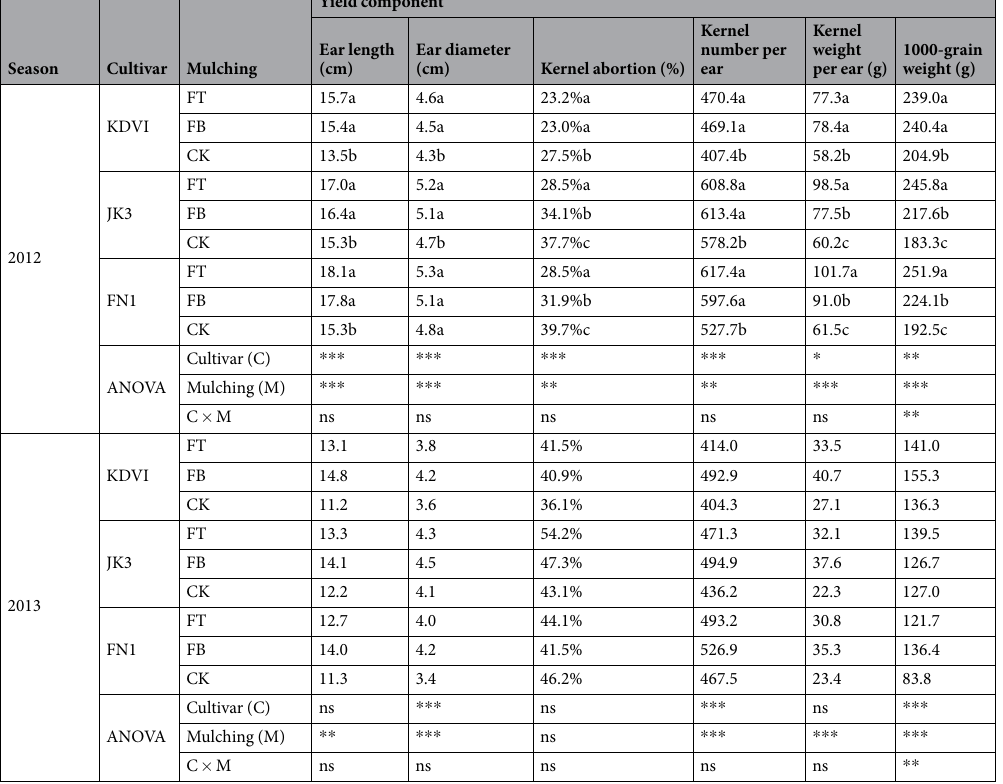
Table 3. Yield components as affected by maize cultivars (early- mid- and late-maturing, KDVI, JK3 and FN1, respectively) and ridge-furrow differingin mulching materials (FT, alternative ridge-furrow with transparent film mulching; FB, alternative ridge-furrow with black film mulching and CK, alternative ridge-furrow with no mulching) in both growing seasons, on a sandy clay loam in Kenya, east African Plateau. Values followed by the same letters in each cultivar are not significantly different at p < 0.05 level. * , ** and *** significant at p < 0.05, 0.01 and 0.001 level, respectively; ns, not